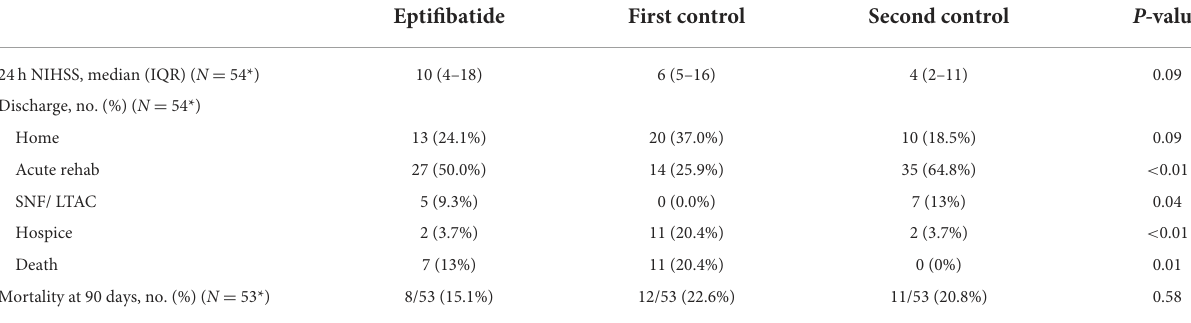
TABLE 3 Discharge and 90 day outcomes.